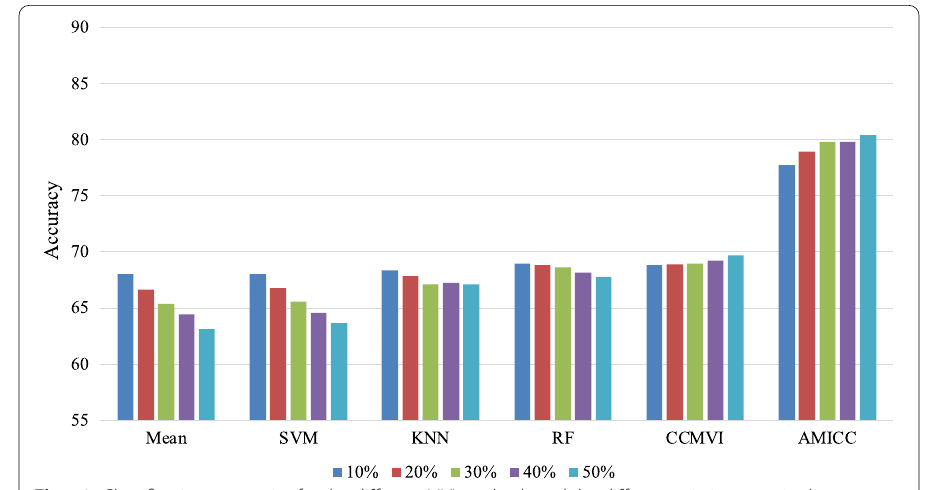
Fig. 13 Classification accuracies for the different MVI methods and the different missing rates in the numerical